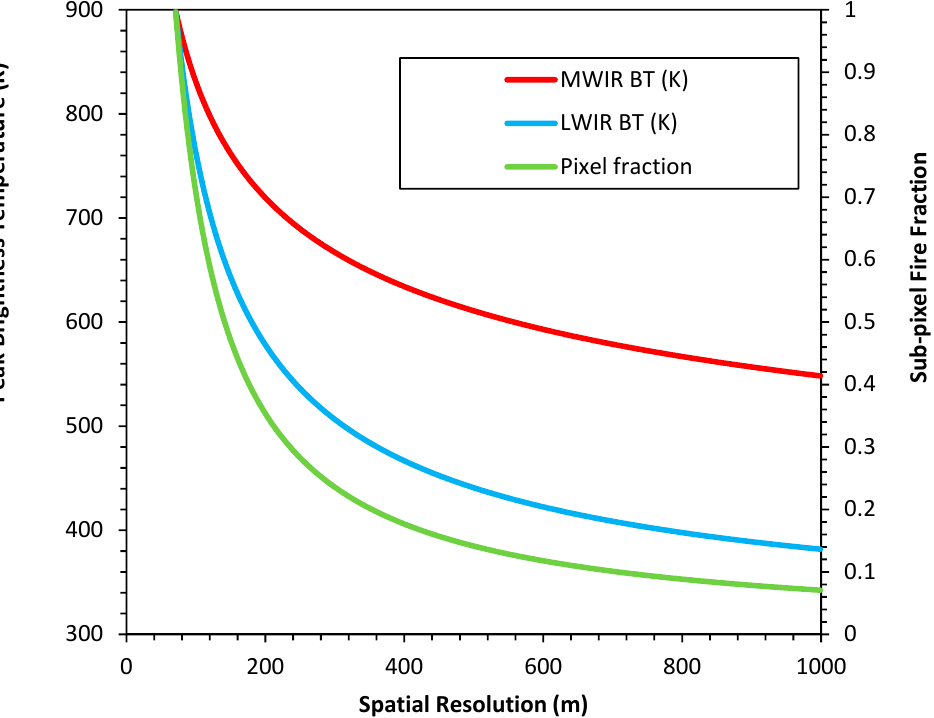
Figure 3. Simulated Infrared (IR) band saturation temperatures as a function of pixel spatial resolution and sub-pixel wildfire area. This simulation assumes a flame front depth of 50 m with mean temperature of 900 K extending diagonally across the pixel. Sub-pixel wildfire area was computed and the saturation temperatures were defined based on the peak pixel brightness temperatures (BT) at a given spatial resolution (Table 5). The saturation temperatures change with spatial resolution in both the LWIR and MWIR, e.g., at 250 m the MWIR and LWIR saturation temperatures are ~690 and ~540 K, respectively, while at 500 m the MWIR and LWIR saturation temperatures are ~610 and ~440 K, respectively. No atmospheric effects on the signal are included in this simulation.